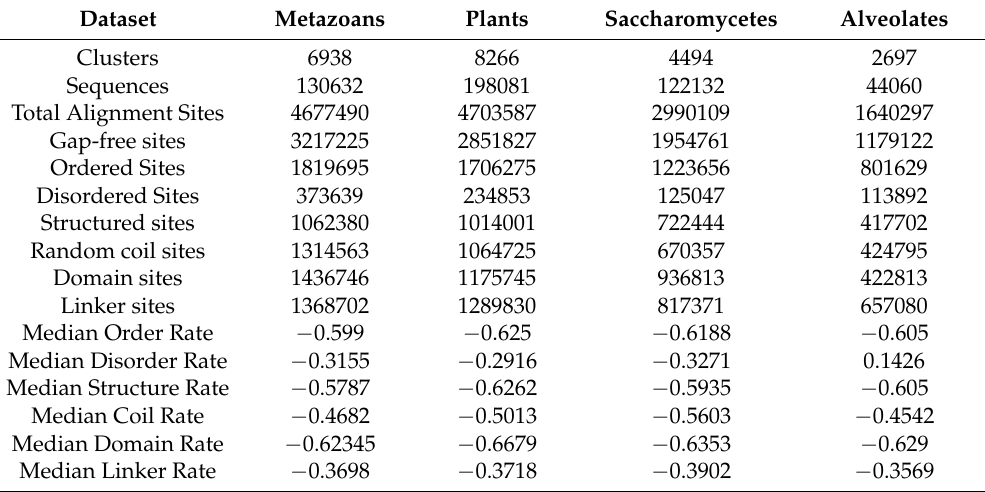
Figure 1. Scatterplots showing minimum pairwise sequence identity (fraction of matching aligned characters) and minimum alignment coverage (seq. length/alignment length) for all Metazoan, Plant, Saccharomycete, and Alveolate clusters used in analyses. Table 1. Dataset-specific information for nonparametric